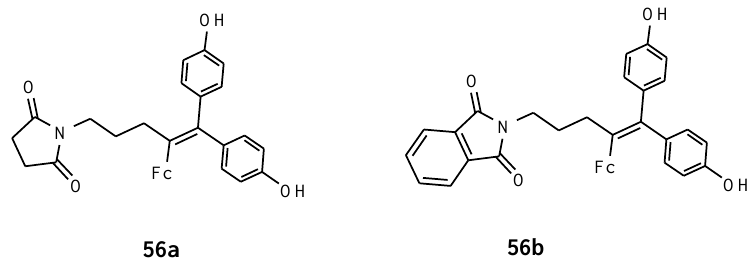
Figure 18. Hybrids 56a and 56b.